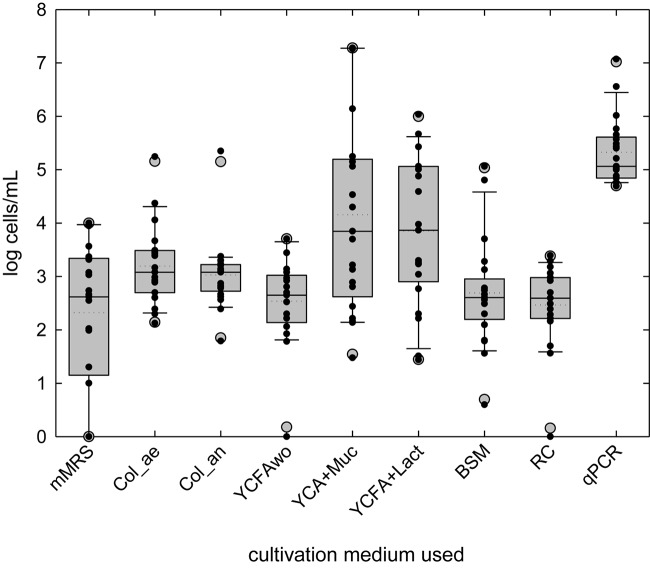
Bacterial load in fresh breast milk investigated by cultivation or quantitative PCR. Boxes indicate the 25th and 75th percentiles. Whiskers indicate 10th and 90th percentiles, 5th and 95th percentiles are shown as dots. The dotted and solid lines indicate mean and median, respectively. (Viable) cell counts of individual samples are indicated by black dots.